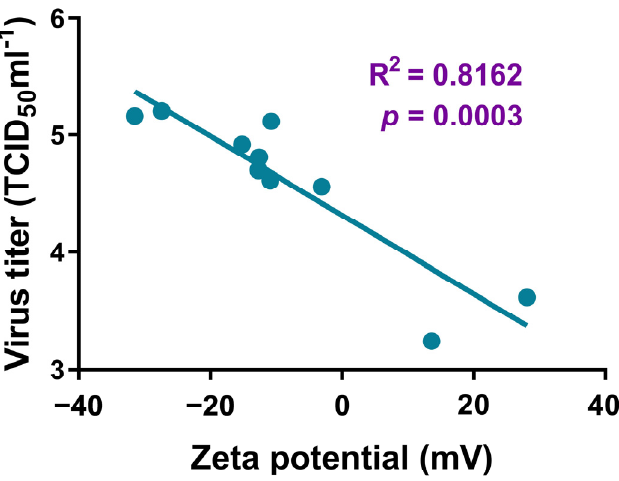
Figure 4. Correlation between the zeta potential of the modified material and virus titer.